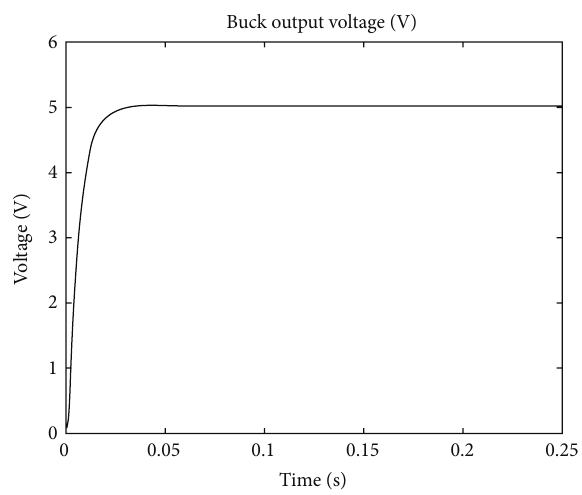
Figure 21: Output voltage of DC/DC converter for a step change in ambient temperature from 30 ∘ C to 20 ∘ C in constant insolation (900 (W/m 2